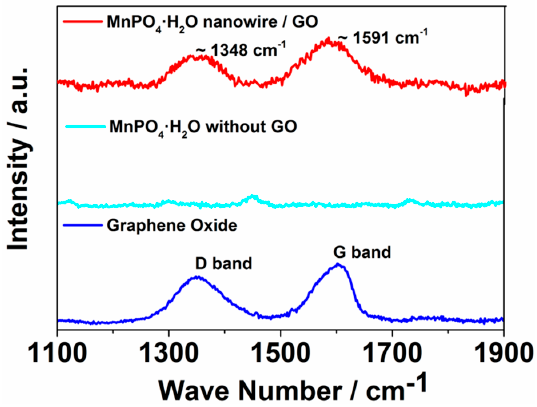
Figure 4. ( a ) C 1s XPS (X-ray photoelectron spectroscopy) of MnPO 4 · H 2 O nanowire/GO composite material; ( b ) Mn 2p 3/2 and 2p 1/2 spectra in this material.